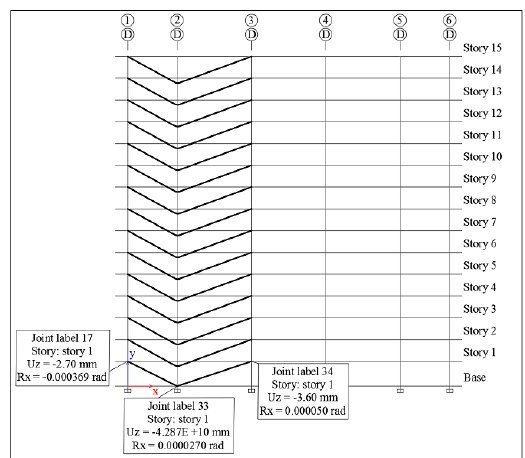
Figure 10. Displacement at notionally removed column D2 (part of grid line D) when moment frames are located at perimeters only (non-linear dynamic case 7).